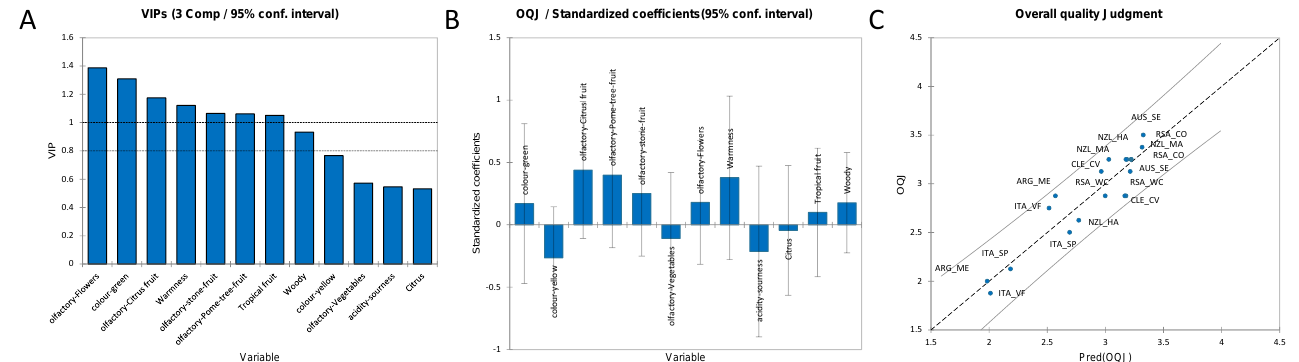
Figure 5. PLS data for the Overall Quality Judgment for the Chardonnay wines. ( A ) shows the VIP for the sensory variables, ( B ) shows the effect of the variables on the PLS equation and ( C ) shows the regression for the OQJ vs. predicted OQJ.